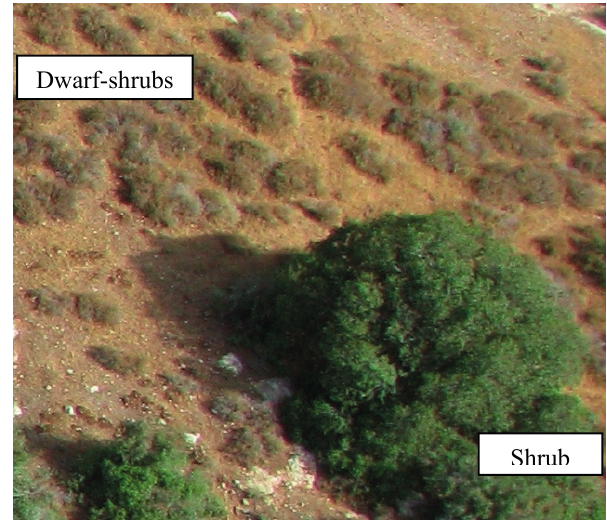
Figure 5. Shrubs and dwarf-shrubs in the Study